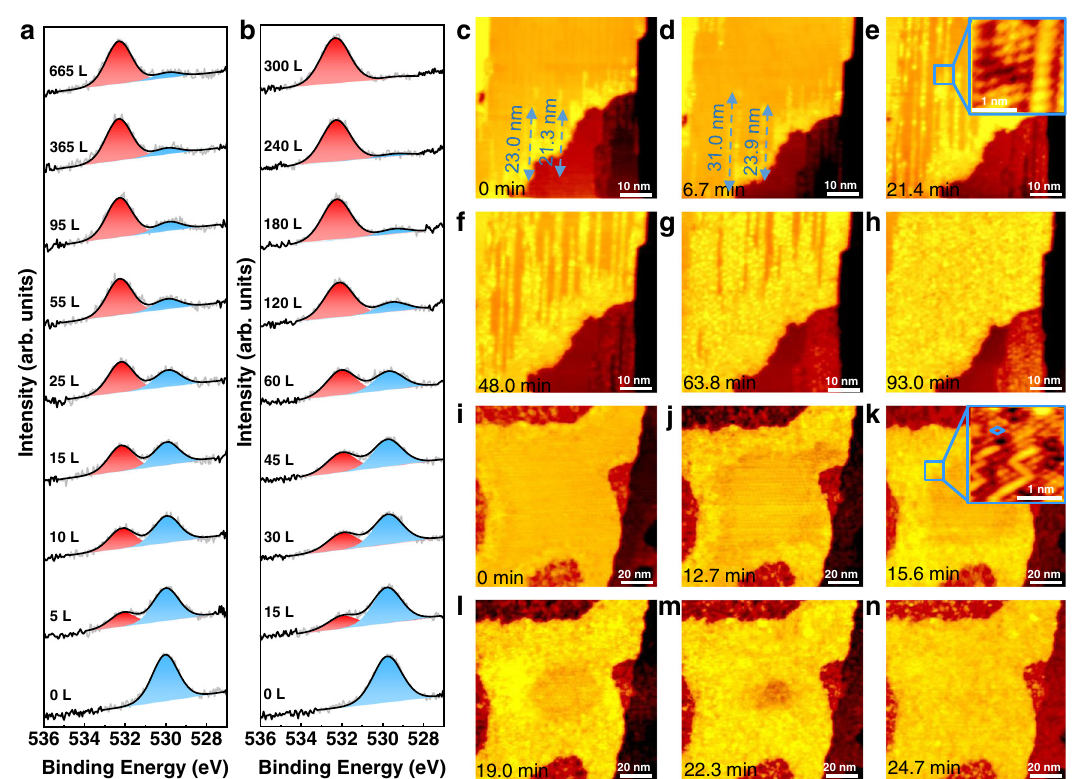
Fig. 2 | The spillover processes on stripe-like MnO/Pt(111) and grid-like Mn 3 O 4 / Pt(111) surfaces. a , b XPS O 1 s spectra of stripe-like MnO and grid-like Mn 3 O 4 surfaces exposed to different amount of D 2 at room temperature. A time-lapse sequence of STM images of ( c – h ) stripe-like MnO and ( i – n ) grid-like Mn 3 O 4 in H 2 atmosphereatroomtemperature.Insetsin( e )and( k )showatomic-resolutionSTM image of partially hydroxylated stripe-like MnO surface and partially hydroxylated